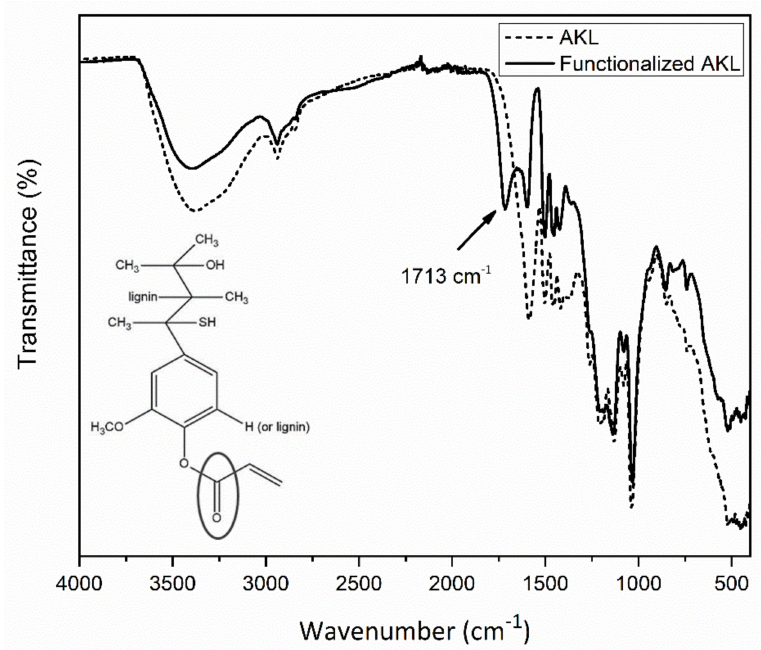
Figure 2. FTIR analysis of the AKL (dash line) and functionalized AKL (straight line).